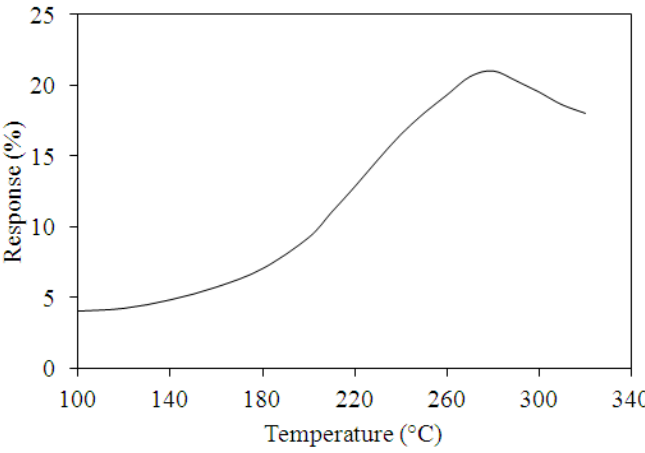
Figure 10. Relation between response and working temperature for the ammonia sensor at 50 ppm NH 3